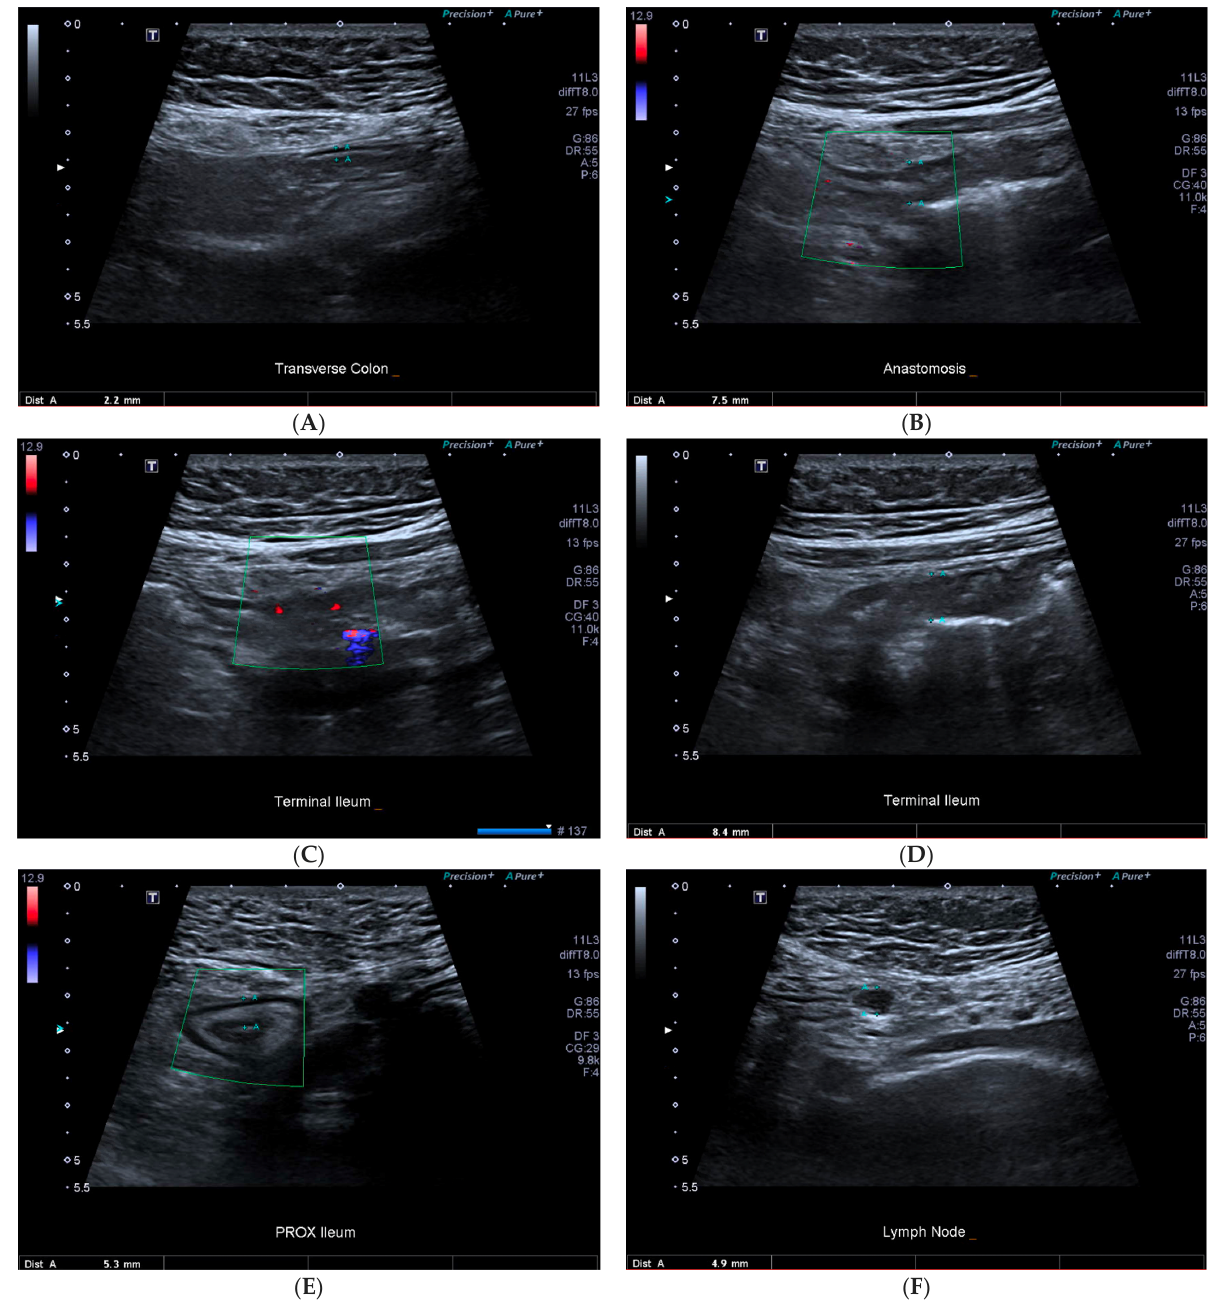
Figure 1. 43 ‐ year ‐ old female with prior ileocolonic resection with CD recurrence at the anastomosis and neoterminal ileum. ( A ) normal transverse colon, ( B ) anastomotic recurrence with increased bowel wall thickening, ( C ) terminal ileum showing Limberg three colour doppler signal, ( D ) terminal ileum wall thickening, ( E ) proximal small bowel wall thickening, ( F ) normal sized lymph node.